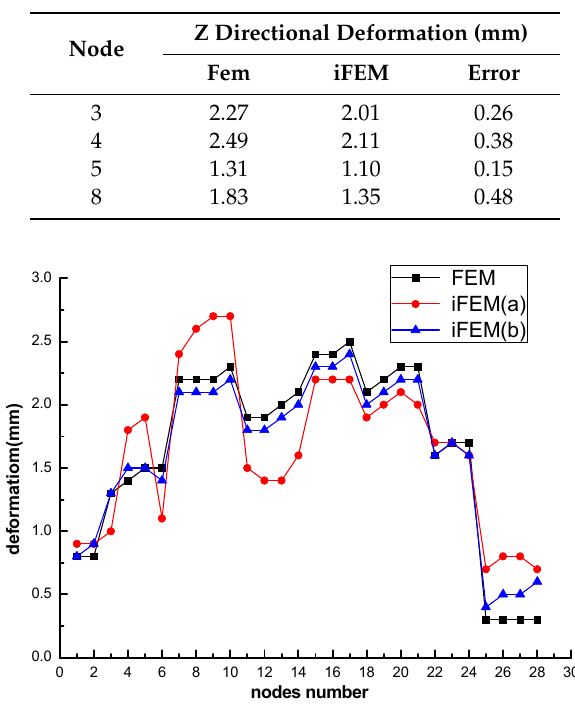
Figure 4. Deformation of the plate structure.